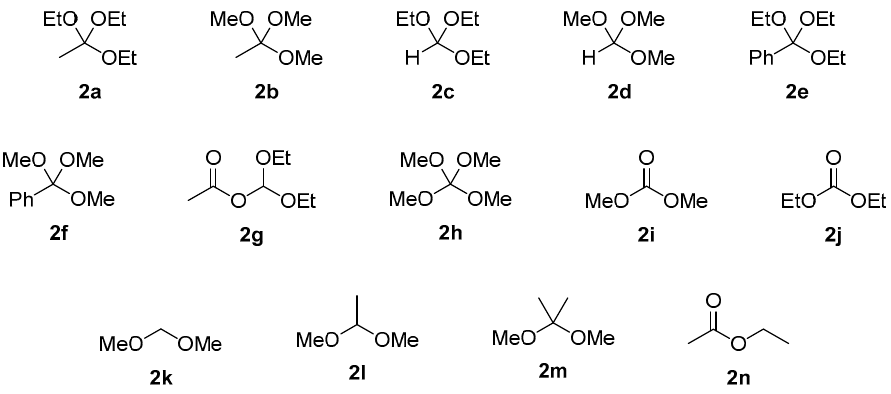
Figure 1. Structures of alkoxy group donors used in experiments. The application of triethyl orthoacetate ( 2a ) as an ethoxy group donor resulting in high conversion, yielding 84% of 3a and 83% of 3b (Table 1, entries 1 and 15). In both cases, excellent selectivity towards monoesters 3a and 3b was observed (yields of diesters 4a and 4b were below 3%). Trimethyl orthoacetate ( 2b ) was found to be a less efficient donor of an alkoxy group, the conversion of acid 1a reached 25% and that of acid 2b was 50% (Table 1, entries 2 and 16). In the case of triethyl orthoformate ( 2c ), trimethyl orthoformate ( 2d ), triethyl orthobenzoate ( 2e ) and trimethyl orthobenzoate ( 2f ), no substrate conversion was observed (Table 1, entries 3–6, 17–20). Along with 2a , diethoxymethyl acetate ( 2g ) was also found to be a selective ethoxy group donor. In reaction with butylphosphonic acid ( 1a ), the conversion of substrate was 39% (Table 1, entry 7) and for phenylphosphonic acid ( 1b ) it was 89% (Table 1, entry 21). The studied transformation was very selective towards monoesters 3 . The application of donor 2g provides a higher conversion of phenylphosphonic acid with respect to butylphosphonic acid. Tetramethyl orthocarbonate ( 2h ) was also active in the esterification reaction, providing ester 3a in 23% and ester 3b in 44% yields, respectively (Table 1, entries 8, 22). When other donors such as dimethyl carbonate ( 2i ), diethyl carbonate ( 2j ), formaldehyde dimethyl acetal ( 2k ), acetaldehyde dimethyl acetal ( 2l ), 2,2-dimethoxypropane ( 2m ) and ethyl ac- etate ( 2n ) were applied, no reaction occurred (Table 1, entries 9–14 and 23–28).